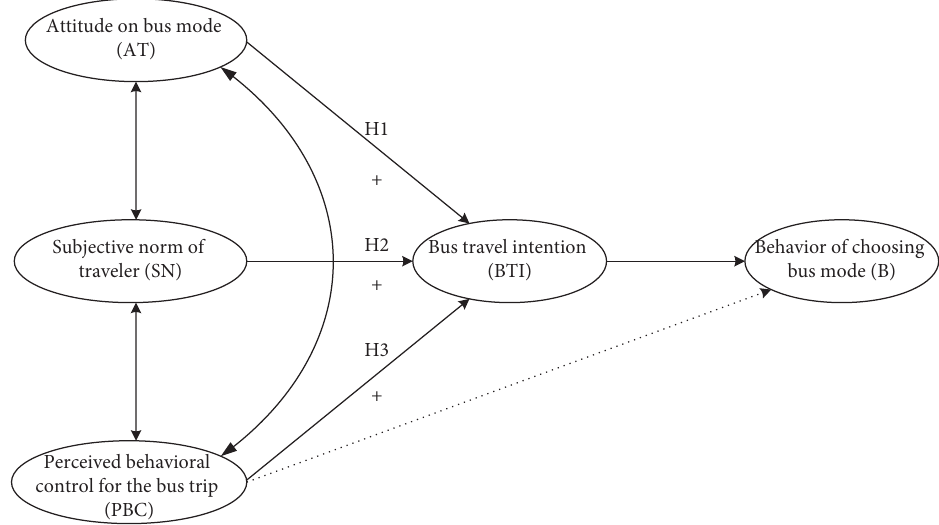
Figure 1: TPB-based model